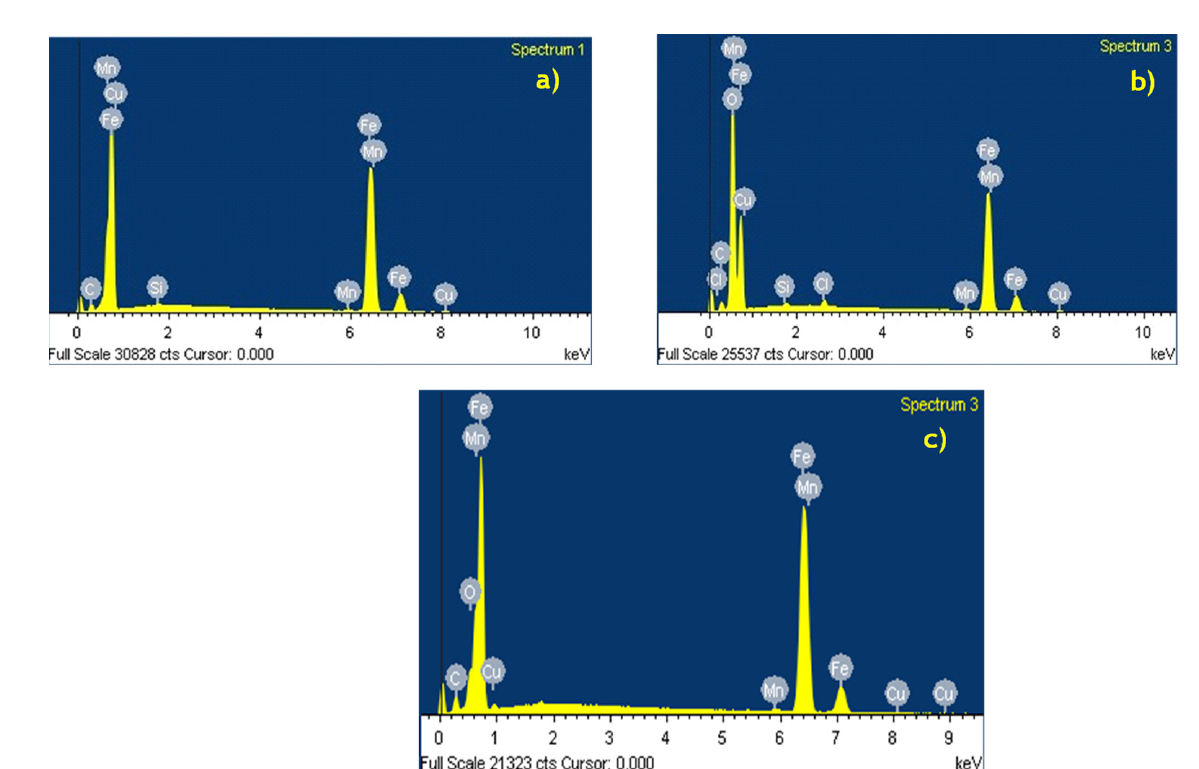
Figure 12. EDX images at 300 X of ( a ) AISI 1018 steel with no-inhibitor; ( b ) AISI 1018 steel immersed in NaCl + CO 2 ; ( c ) 10 ppm 4-PC + NaCl + CO 2 after 24 h.